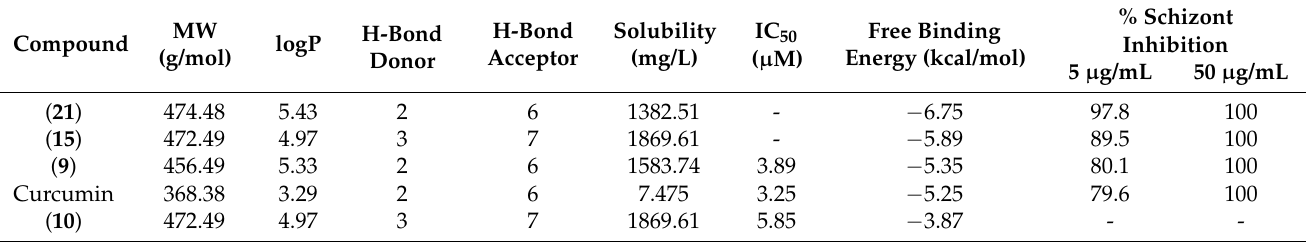
Figure 15. Curcumin derivative whose active methylene group is substituted by Knoevenagel condensation. Table 3. In vitro and in silico assessment of antimalarial activity of curcumin derivatives by Dohutia et al. [37].